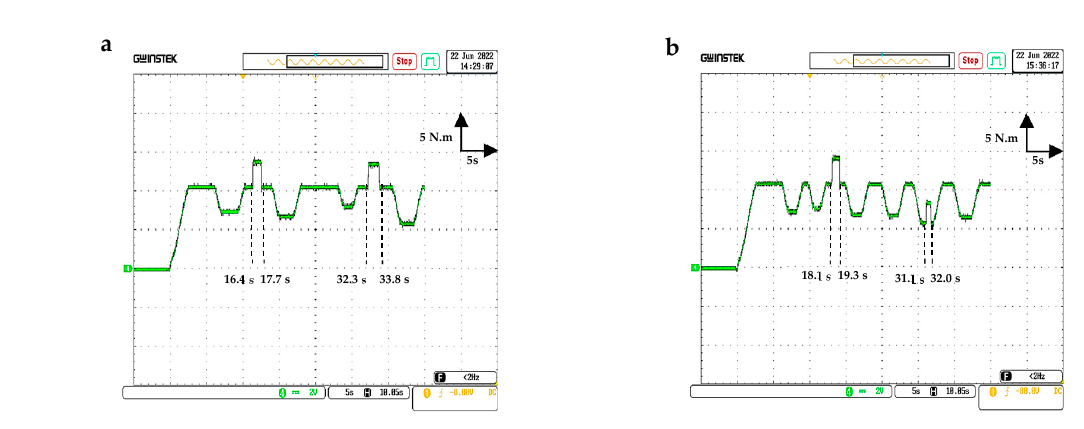
Figure 24. Estimated load torque for speed profile 1 and 2.